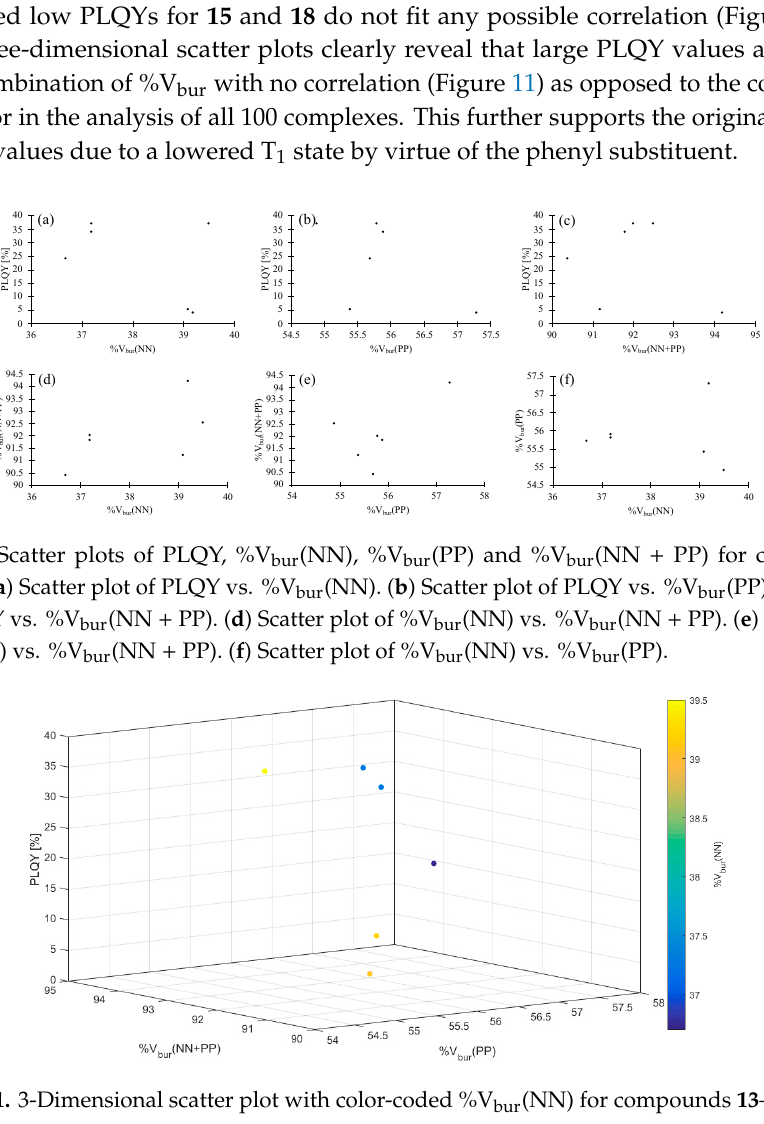
Figure 9. Structures of complexes 13 – 18 from reference [18]. Table 3. Reported PLQY values for powder samples for copper(I) complexes and %V bur for (NN), (PP), and (NN)(PP) units. Data are from reference [18].